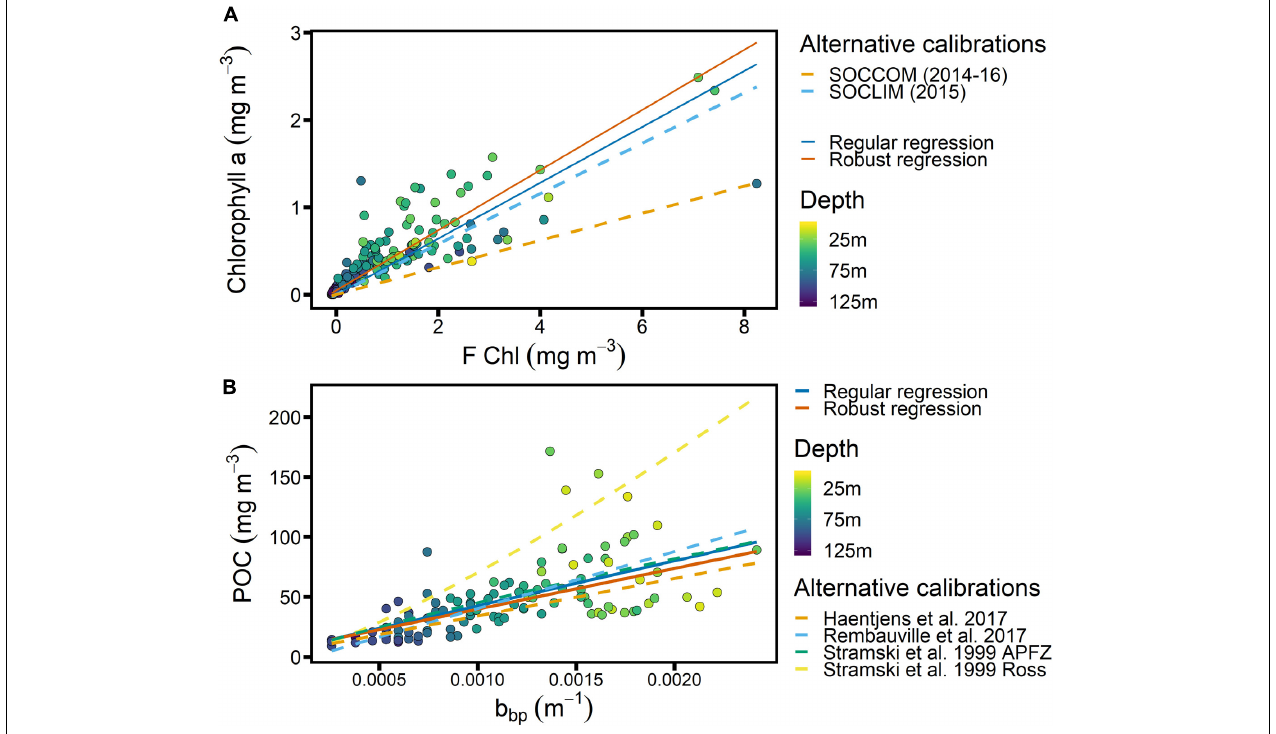
FIGURE 4 | Calibrations obtained from SAZ-Sense voyage data, color-coded based on sampling depth. (A) Relationship between chlorophyll fluorescence (FChl, manufacturer calibration) and Chl from discrete samples analyzed by HPLC. Calibrations from SOCCOM (2014–2016; Southern Ocean) and SOCLIM (2015; Kerguelen Island region) are shown for comparison (Roesler et al., 2017). Note that night-time data from shallower than 25 m depth are included. (B) Relationship between POC and particulate backscatter, with literature calibrations from the following regions shown for comparison: Southern Ocean (Haentjens et al., 2017); Kerguelen Island region, between 35 and 60 ◦ S (Rembauville et al., 2017); Antarctic Polar Front Zone (Stramski et al., 1999); Ross Sea (Stramski et al.,